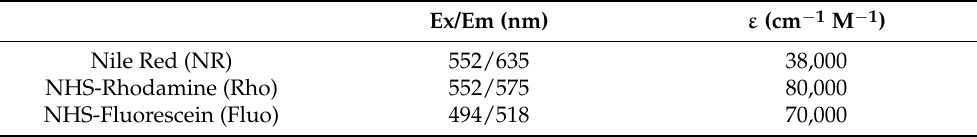
Table 2. List of fluorophores, respective excitation and emission wavelengths, and molar extinction